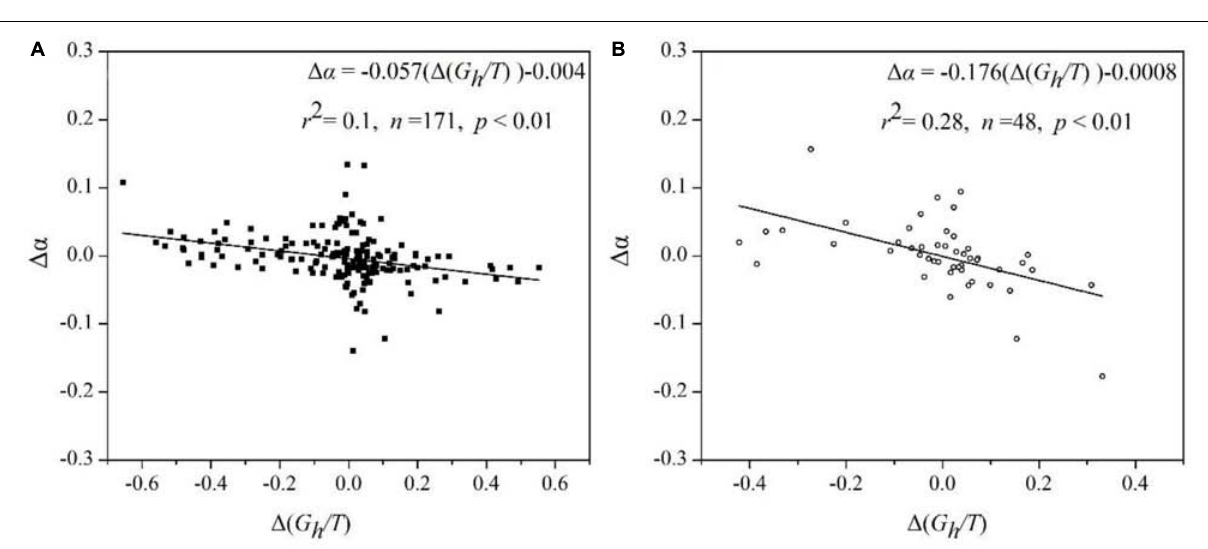
derived from the Landsat image is the average value for a 30 m × 30 m